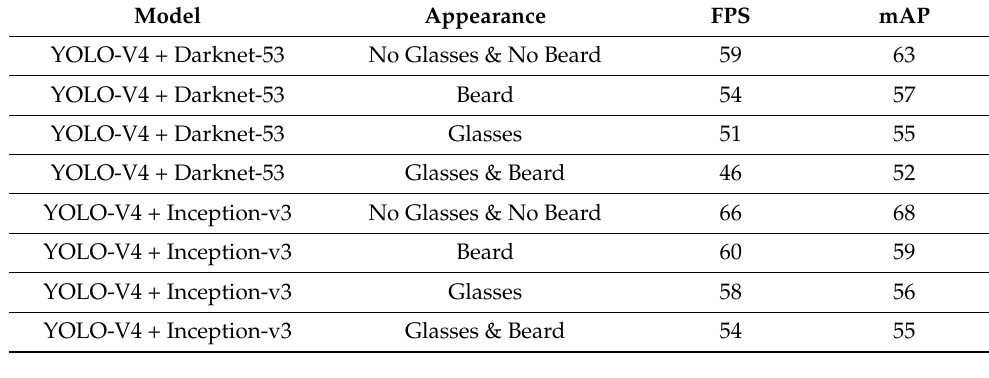
Table 4. Performance comparison between YOLO-V4 Darknet-53 and YOLO-V4 Inception-v3.